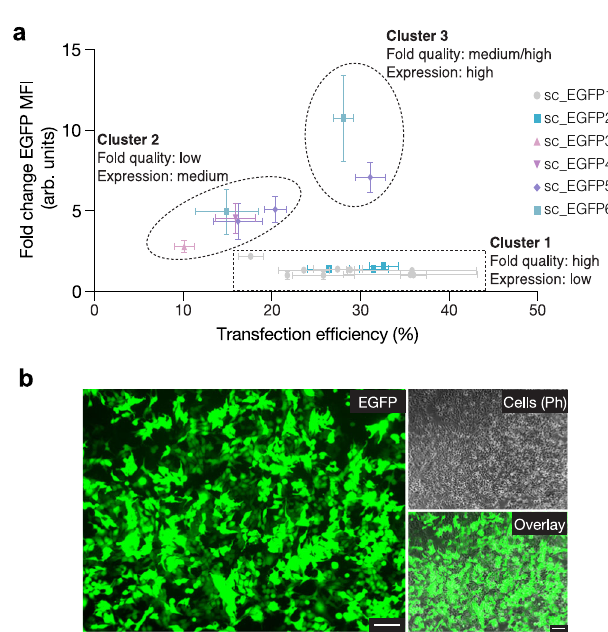
Fig. 4 | Enhancing gene expression through scaffold sequence design. a 20HB design for the sc_EGFP5 structure included an external single-stranded loop to allow the ITR sequence to self-anneal and form the hairpin structure. 20HB design for the sc_EGFP6 scaffold included two external loops to expose the ITR binding domain,enabling theITRhairpinstaplesto anneal. b , c Transfection ef fi ciencyand MFI in HEK293T cells seen for 20HB-exLP structures folded with sc_EGFP5 and sc_EGFP6. Higher transfection ef fi ciencies and MFI were observed for 20HB-exLP objectsfoldedwithsc_EGFP5( p =0.0002, p =7.99×10 − 5 )andsc_EGFP6( p =0.0134, p =4.6×10 − 8 ) compared to sc_EGFP1 20HB. In addition, 20HB-exLP folded with sc_EGFP6 demonstrated higher MFI than 20HB-exLP folded with sc_EGFP5 ( p =0.0169).Datacollectedin b and c werequanti fi edusing fl owcytometryandare presentedasmean±s.d.for n =3biologicallyindependentexperiments,individual data points are overlaid, controls are unfolded scaffold and staple mixture ‘ sc + st ’ and scaffold only ‘ sc ’ , 0.5 µ g total DNA per condition, source data provided. Sta- tistical analysis in b and c was performed using one-way ANOVA with Tukey ’ s multiple comparison, (* p ≤ 0.05, *** p ≤ 0.001, **** p ≤ 0.0001, ns p >0.05). d Representative epi fl uorescence microscopy images showing EGFP expression fromcellstransfectedwithDNAorigamiobjectsfoldedwithsc_EGFP5andsc_EGFP6 relative to sc_EGFP1. Images in the bottom row have been purposely contrast enhanced to reveal EGFP positive cells that have poor EGFP intensity in the sc_EGFP1 sample. The images are representative of one of n =3 biologically inde- pendent experiments; similar results were observed each time. Scale bar 100 µ m.